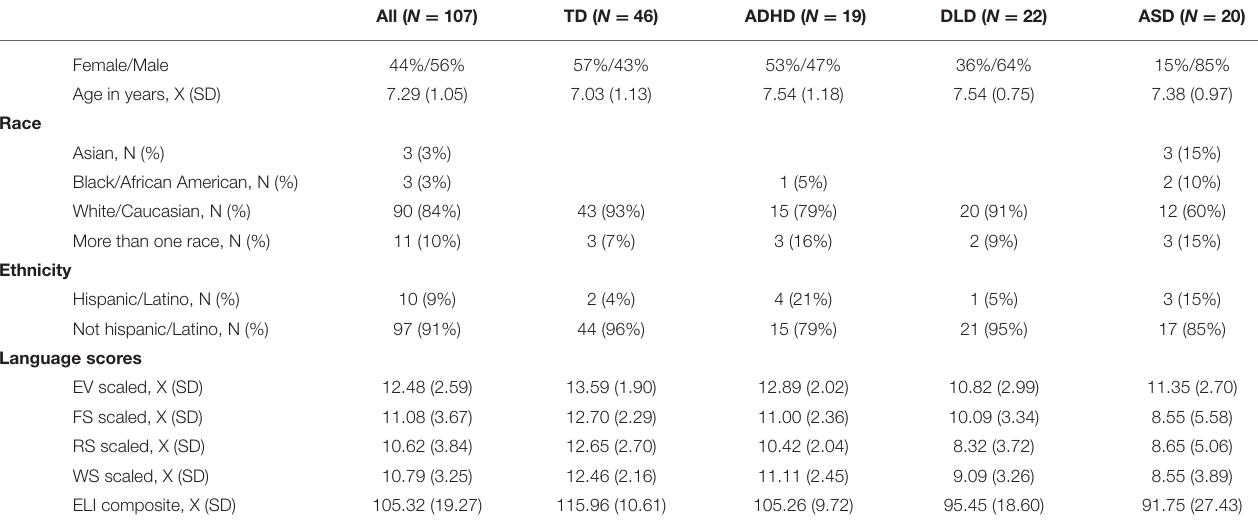
TABLE 1 | Baseline characteristics of